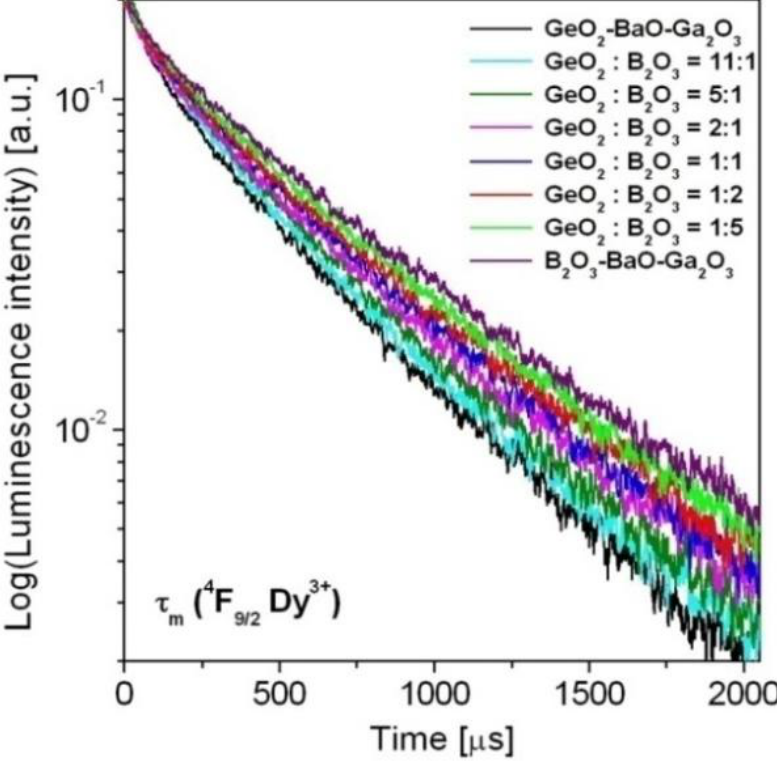
Figure 8. Luminescence decay curves for the 4 F 9/2 state of Dy 3+ ions in borogermanate glasses. Based on decay curve measurements, luminescence lifetimes for the 4 F 9/2 state of Dy 3+ ions were determined. Next, measured lifetimes were compared to the radiative lifetimes (Equation (5), Part 3) calculated from the J–O theory. Both measured τ m and radiative τ rad lifetimes were used to calculate quantum efficiency (Equation (6), Part 3). The measured lifetimes and quantum efficiencies for the 4 F 9/2 state of Dy 3+ varying with GeO 2 :B 2 O 3 molar ratios are schematically shown in Figure